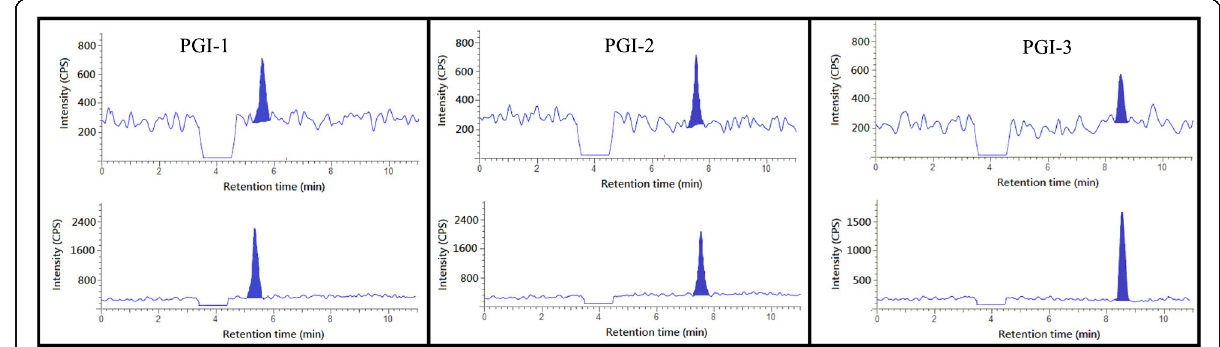
Fig. 5 MRM chromatograms of PGI-1, PGI-2, and PGI-3 for their evaluation of LOD and LOQ